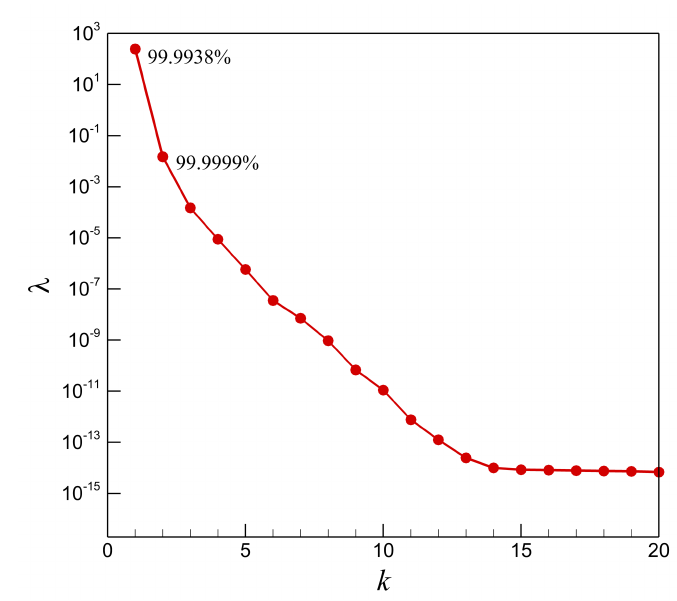
Figure 7. Eigenvalues of the correlation matrix of stream function data.